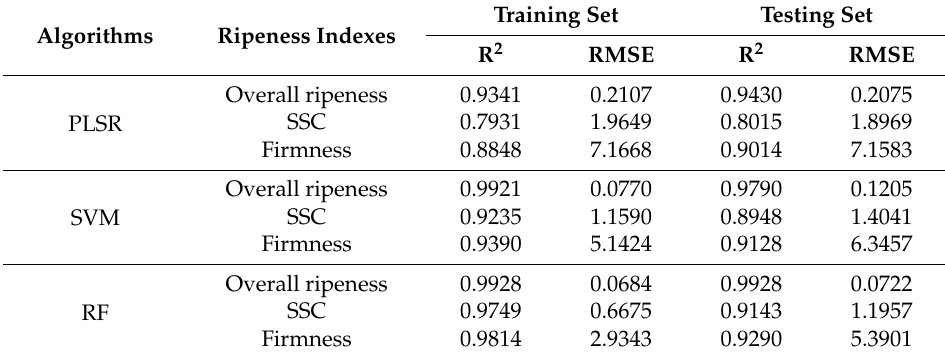
Table 6. The results of evaluating parameters for prediction models based on PLSR, SVM and